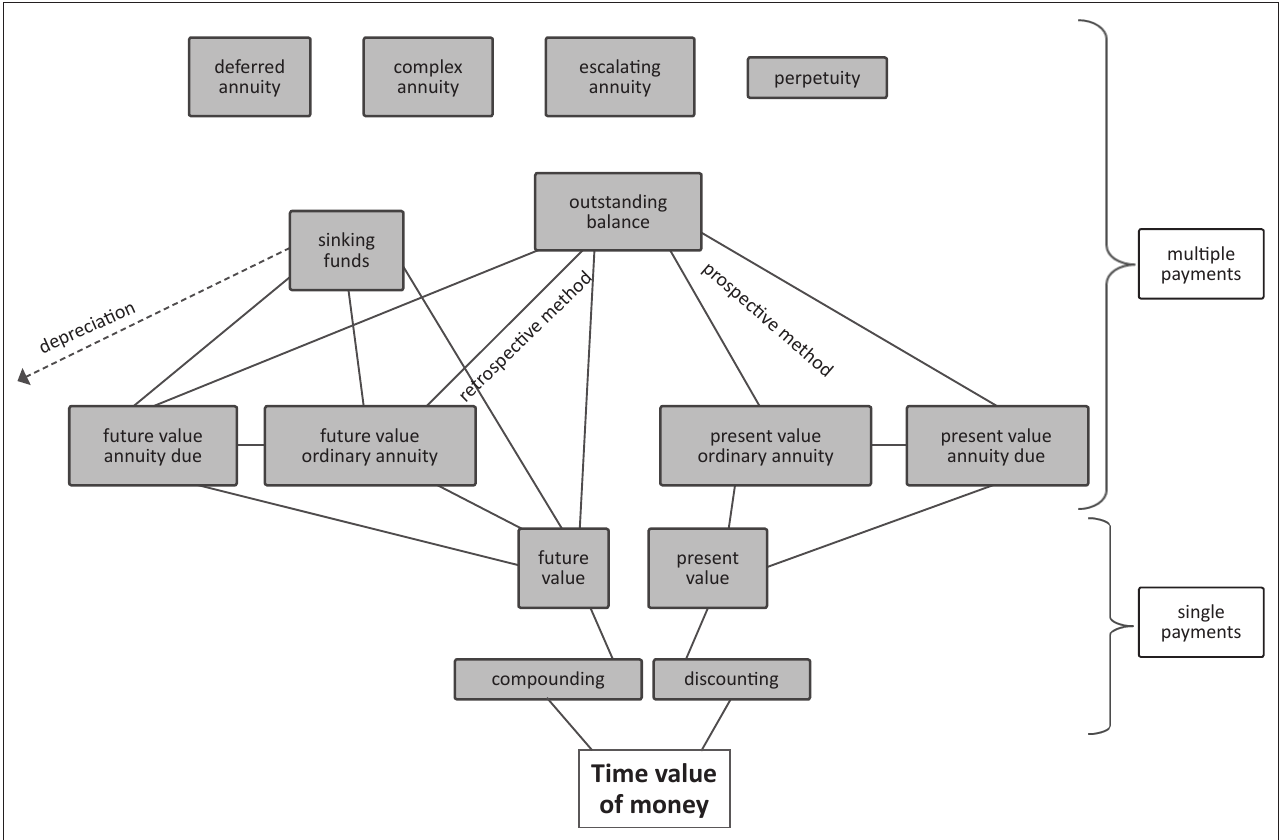
FIGURE 1: A hierarchy of annuities